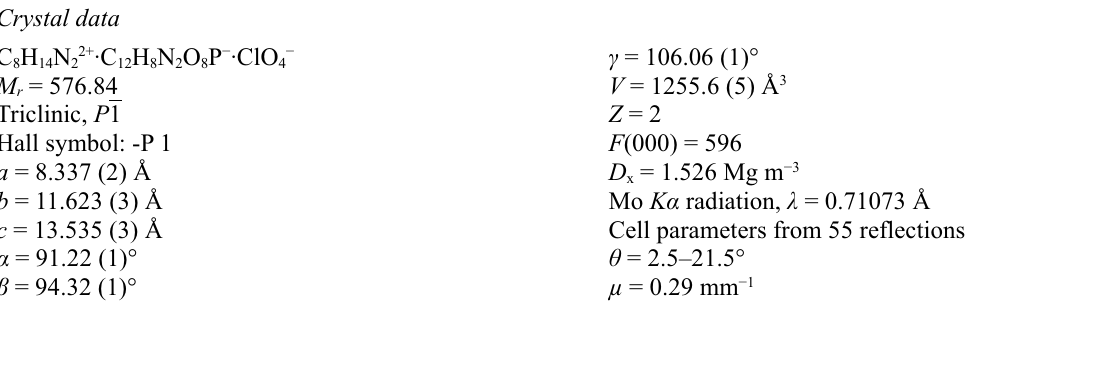
The packing arrangement viewed down the b axis showing the N—H···O and C—H···O interactions (dashed bonds). ( m -Phenylenedimethylene)diammonium p -nitrophenylphosphate perchlorate Crystal